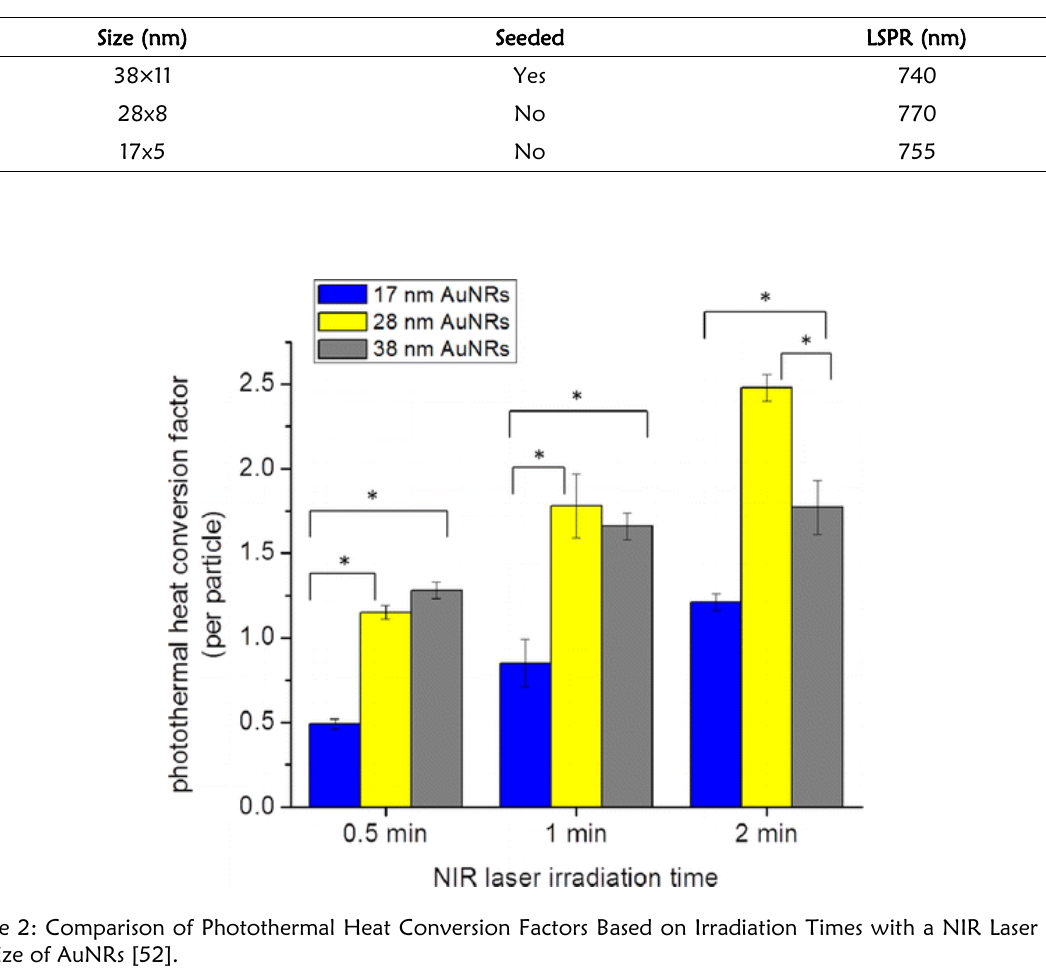
Table 3: Overview of AuNR’s Parameters [52]